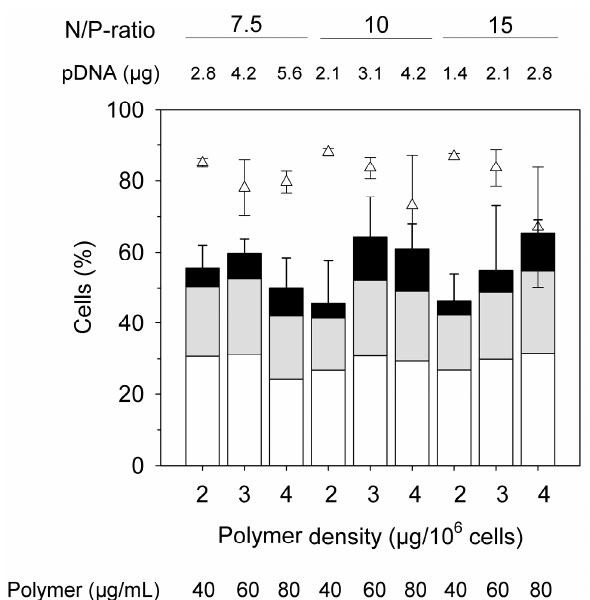
Figure 5. HCD transfection as a function of the N/P ratio and the polymer density. (Total cell number: 5 × 10 6 cells, transfection volume 0.25 mL, 2 mL Eppendorf tube, amount of pDNA is given per sample. Bars represent the percentage of transfected cells, with white: low producers, grey: middle producers, black: high producers; (cid:52) : viabilities. Shown are mean values ± SD, n ≥ 3, SD given for total transfection efficiencies and for viabilities.)